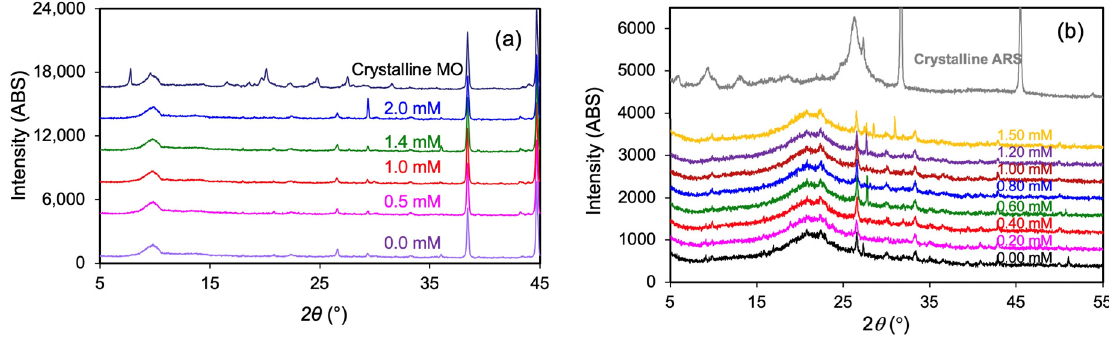
Figure 4. XRD patterns of clinoptilolite after MO ( a ) and ARS ( b ) sorption from different initial con- Figure 4. XRDpatternsofclinoptiloliteafterMO( a )andARS( b )sorptionfromdifferentinitialconcentrations. centrations.